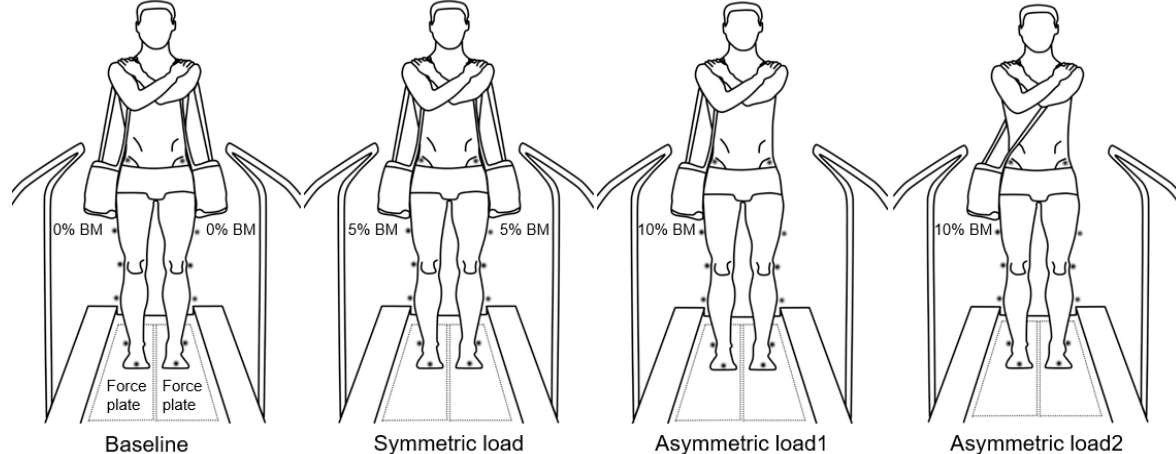
Figure 1. Illustration of four different load conditions. Baseline (no load with one messenger bag on each shoulder hanging vertically down to the hips) symmetric load (5% of body mass in messenger bags on each shoulder hanging vertically), asymmetric load 1 (10% of body mass messenger bag on one shoulder hanging vertically against ipsilateral hip), and asymmetric load 2 (10% of body mass messenger bag on one shoulder with the bag draped across the trunk to contralateral hip).